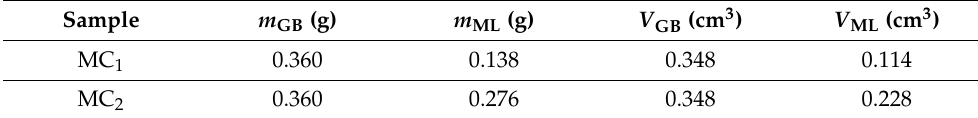
Figure 2. Magnetization M as a function of intensity H of the magnetic field, for: ( a ) ML. ( b ) MC. For MC manufacture, two pieces of material are cut from GB, in the form of a square with an edge size L = 30 mm. The fabrics are then introduced inside two Berzelius glasses together with a volume of 2 cm 3 of ML. After one hour, the fabrics, impregnated with ML, are deposited on absorbent papers. In order to extract the excess ML from within the fabrics, they are pressed against the filter papers. This procedure is performed such that the remaining ML is removed, while the quantities of ML impregnated in the fabrics differ by a factor of two between the composites. At the end of this step, the quantity of ML is measured with the help of an analytic balance (AXIS 60 type). The corresponding masses and volumes of both GB and ML for the two composites are listed in Table 1. Table 1. Masses ( m ) and volumes ( V ) of the components of the two composite materials. Sample